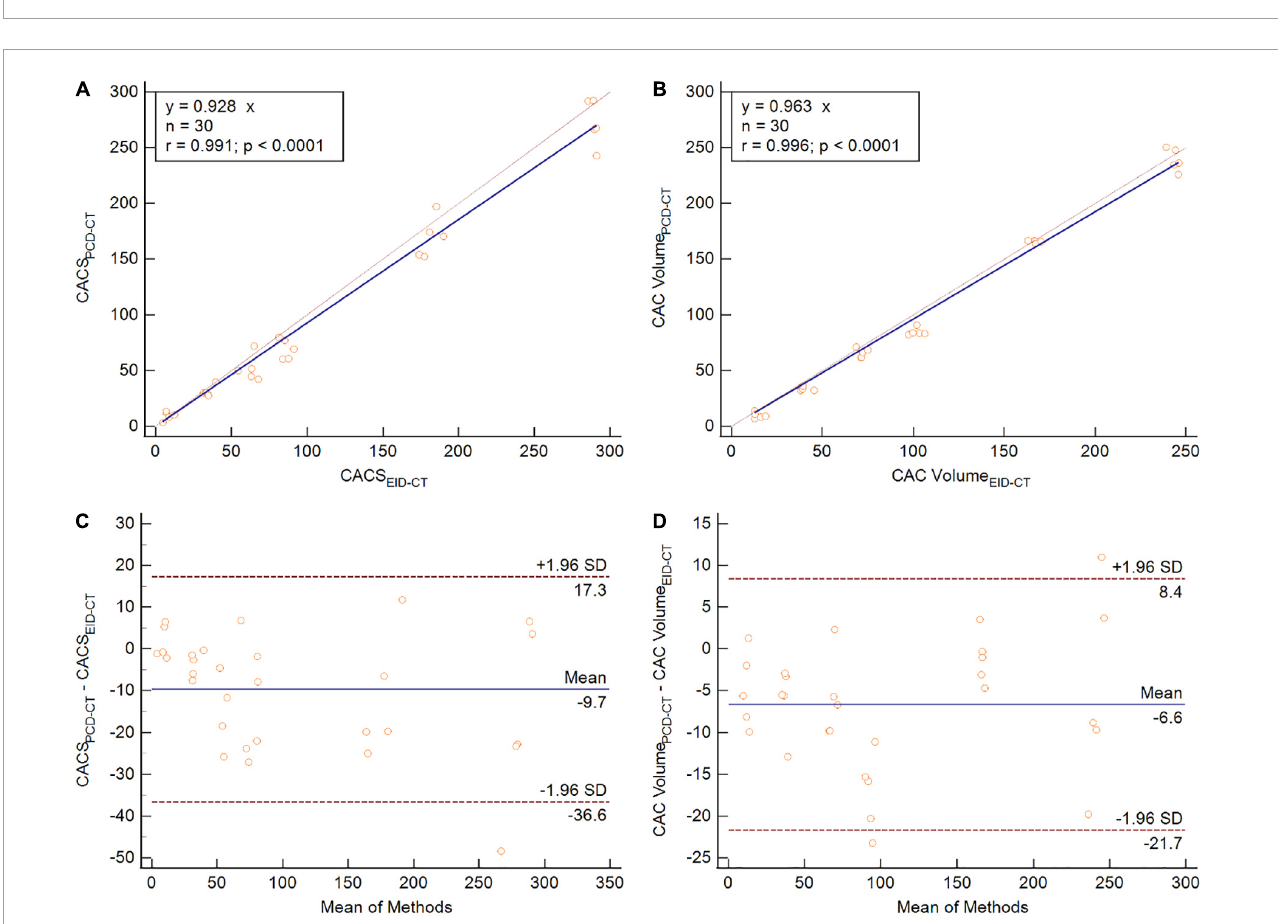
lower in PCD-CT imaging compared to the EID-CT (CTDI vol 2.4 (1.5–3.1) mGy and 2.9 (1.7–3.1) mGy, p = 0.0001). Details of the